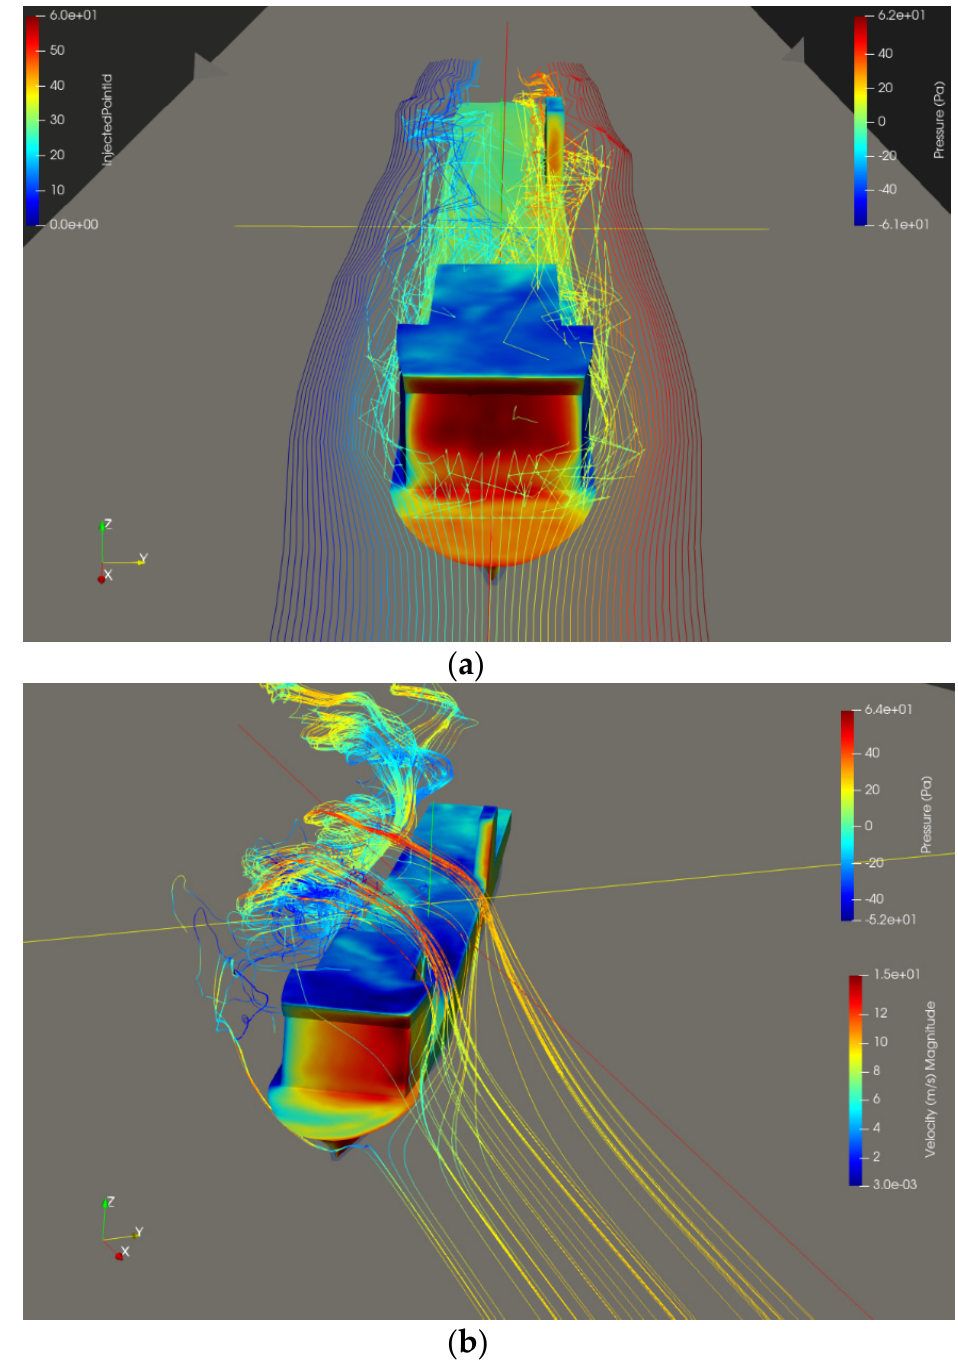
Figure 12. Streamlines and pressure on ship surfaces for inflow wind conditions of 0 ( a ) and 30 ( b ) degrees of relative wind inflow angle. Source: Own elaboration.